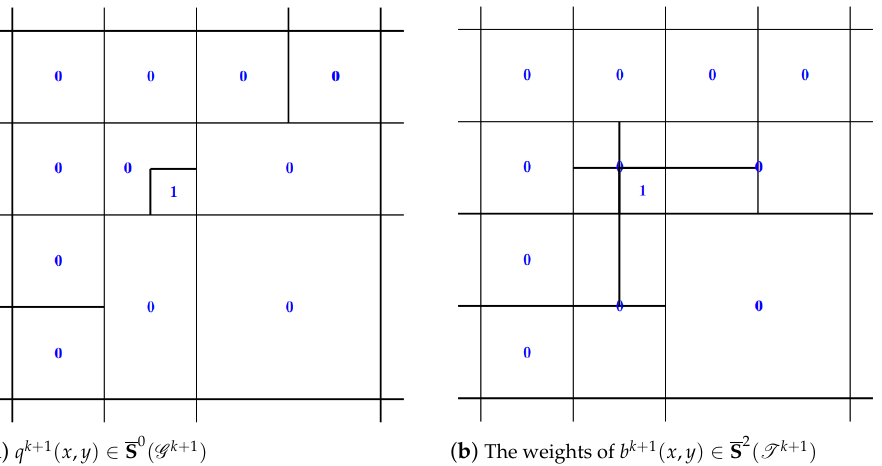
Figure 9. Weights initialization. The 0 and 1 in ( a ) denote the value on each g-cell that belongs to a part of G k + 1 ; The 0 and 1 in ( b ) denote the corresponding initialized